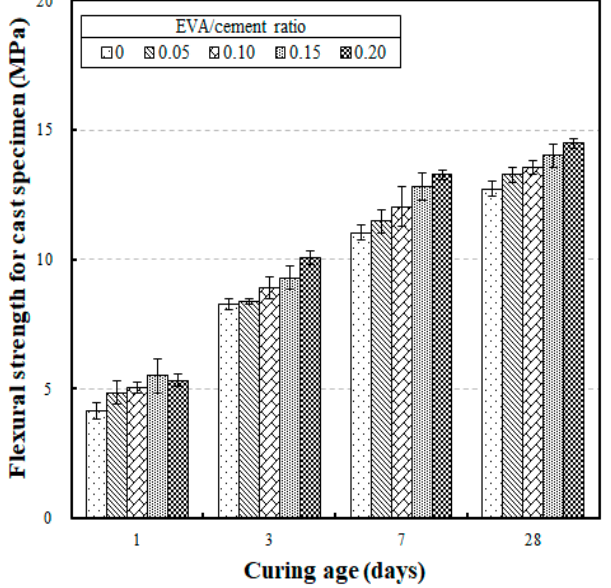
ff erent EVA / cement